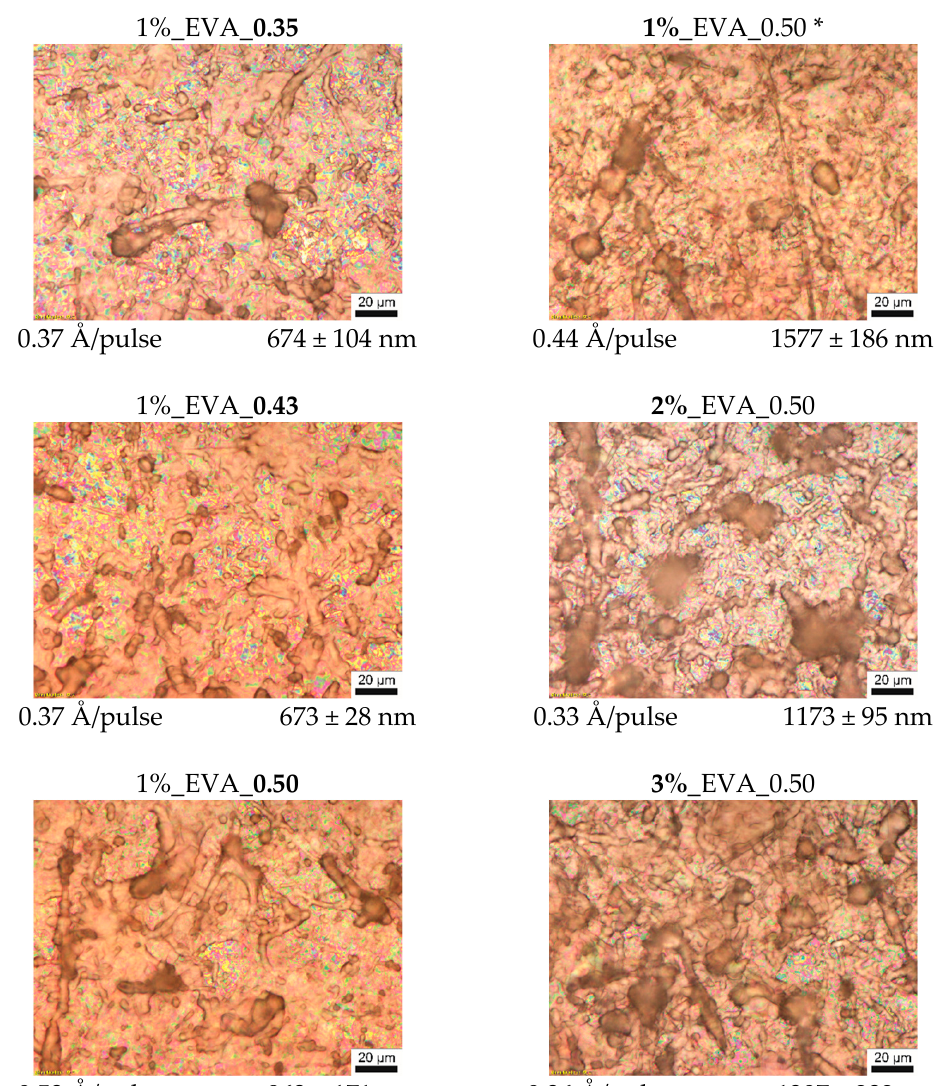
Figure 1. Optical micrographs of two series of EVA films with the values of process efficiency and coating thickness indicated for each sample.